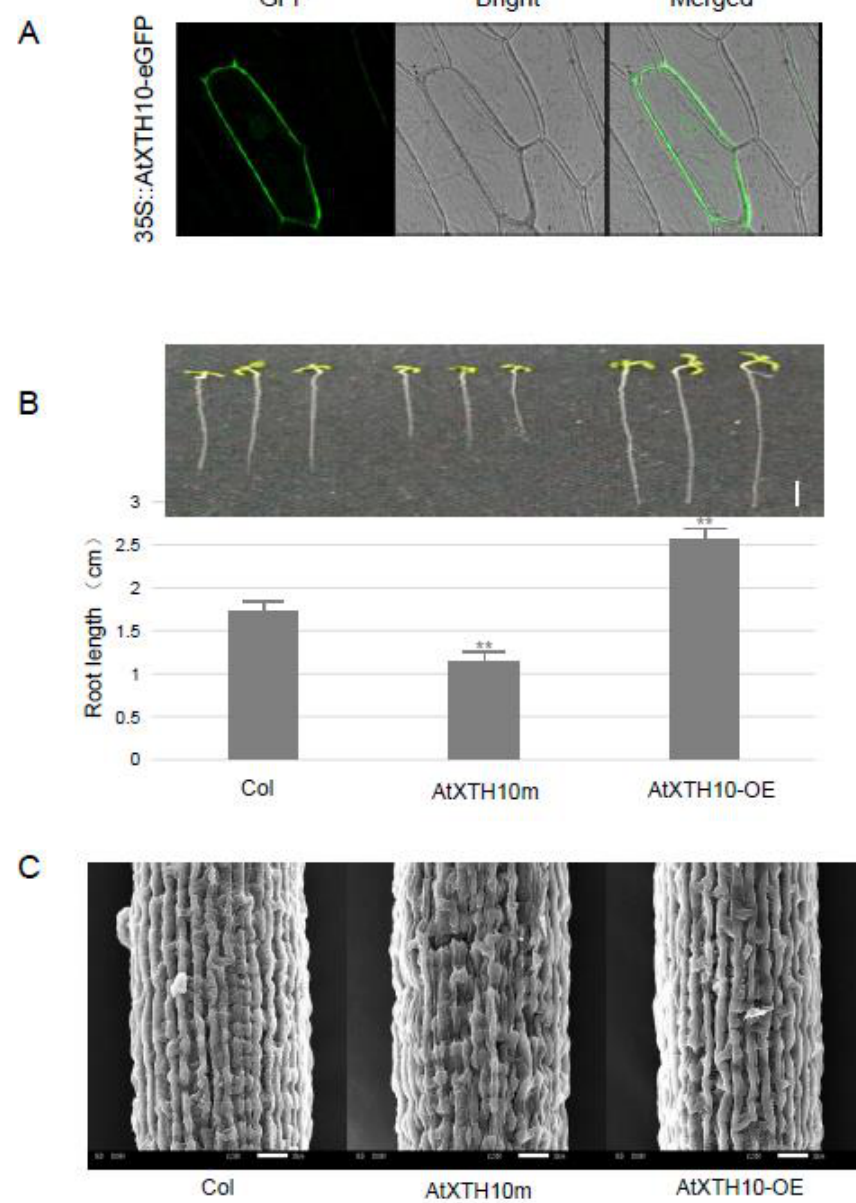
Figure 3. Subcellular localization of AtXTH10 protein ( A ), phenotypic analysis of AtXTH10 gene affecting root development (scale bar stands for 0.5 cm) ( B ), and scanning electron microscope observation of root microstructure (scale bar is 10 µ m) ( C ). Significance was tested relative to the wild type (Col) using t -test. Significance of ** p < 0.01. Error bar: standard deviation.